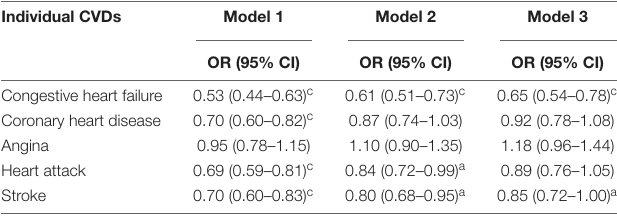
TABLE 2 | Logistic regression results for relationship between Klotho (log2 transformation) and specific cardiovascular disease (CVD).